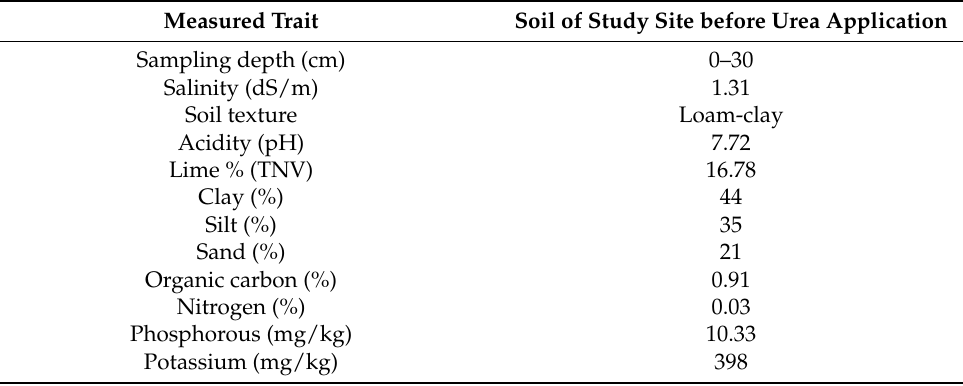
Table 2. The physicochemical characteristics of soil in the study